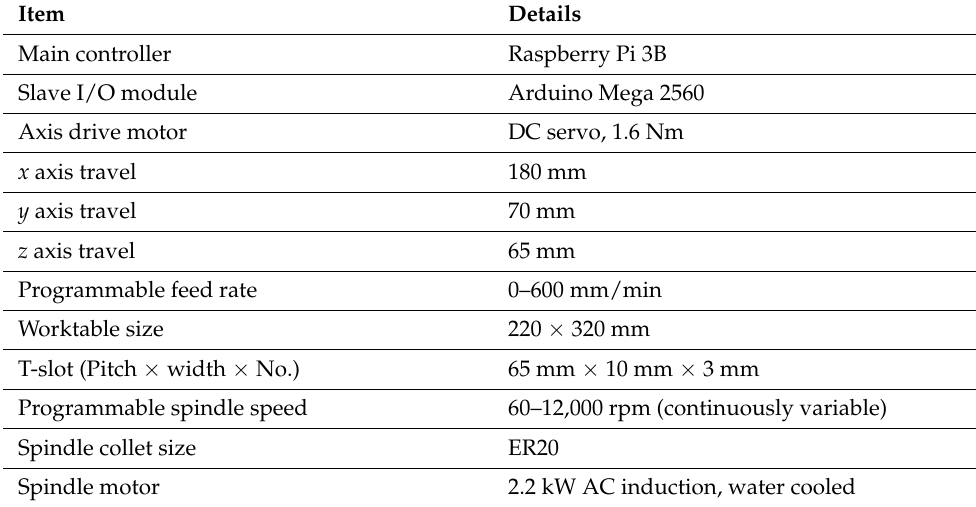
Table 1. Specification of newly developed CNC